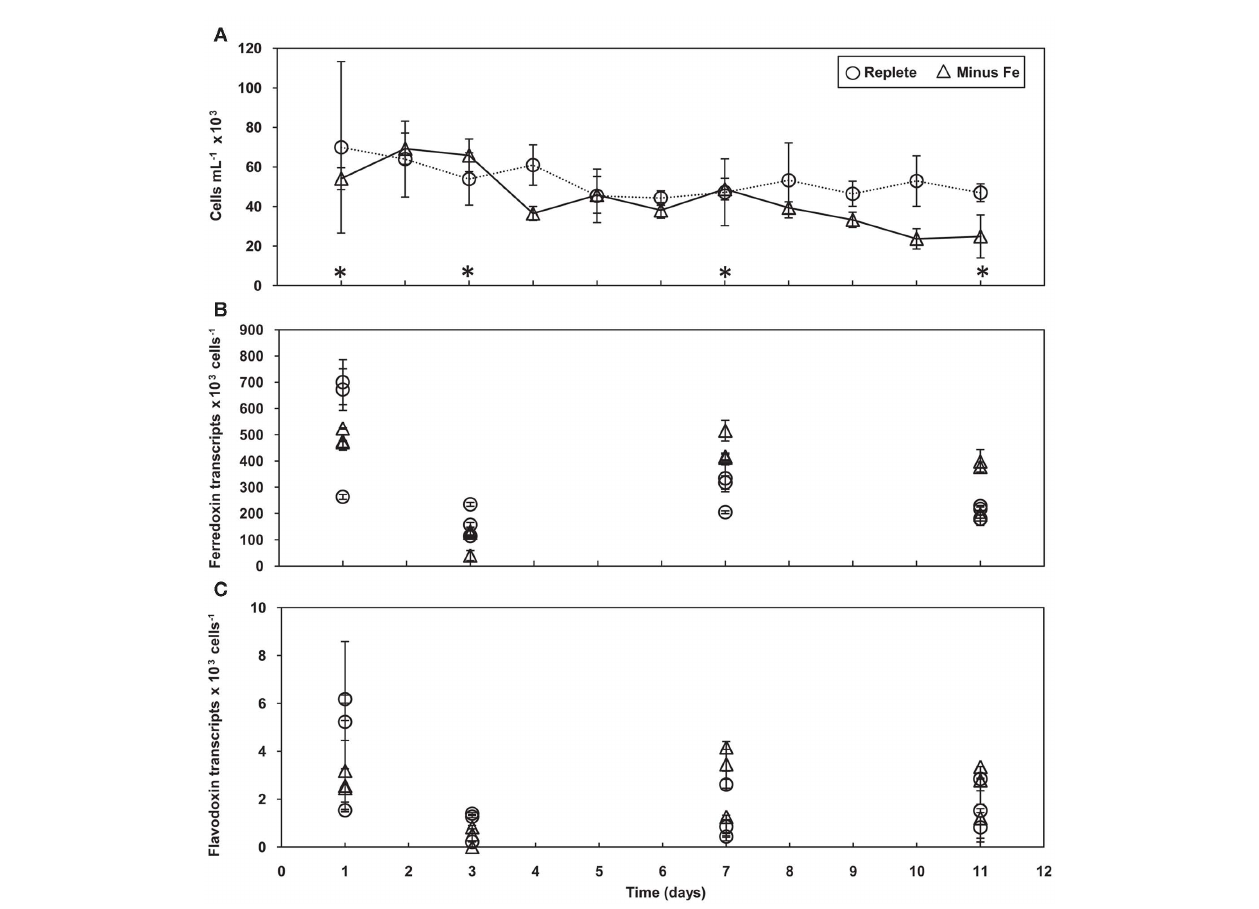
ferredoxin and (C) flavodoxin normalized to cell number. Results from each culture replicate are shown. Error bars represent the SD of triplicate relative transcript abundance determinations (separate cDNA syntheses) for each culture